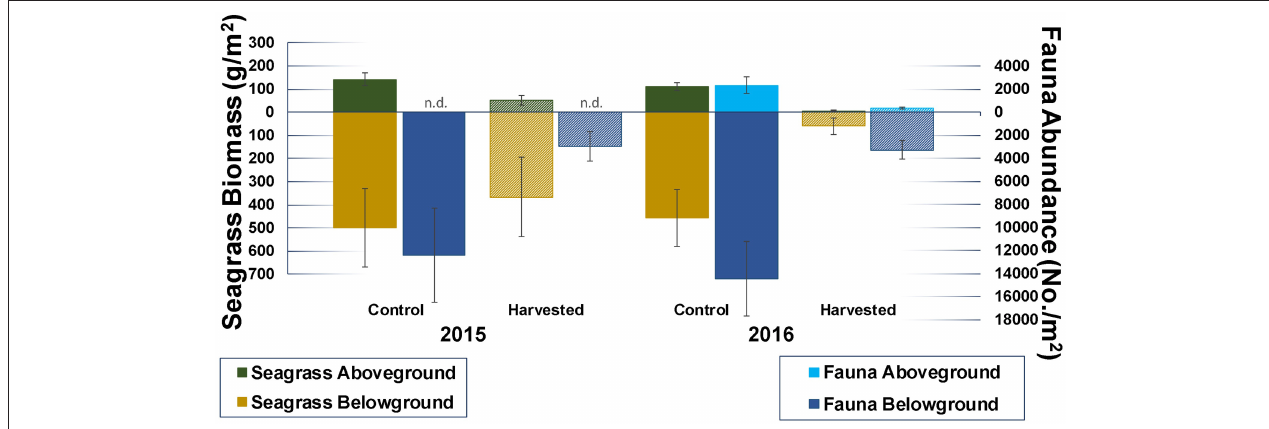
FIGURE 8 | Mean ( ± SE) faunal abundance in control and harvested plots one and 13 months after the start of the experiment (2015 and 2016, respectively). Aboveground fauna was sampled using drop samples (2016 only), belowground fauna and seagrass biomass were sampled using cores. Seagrass aboveground biomass contains shoots, belowground biomass roots and rhizomes. Harvested plots appear in a raster pattern.